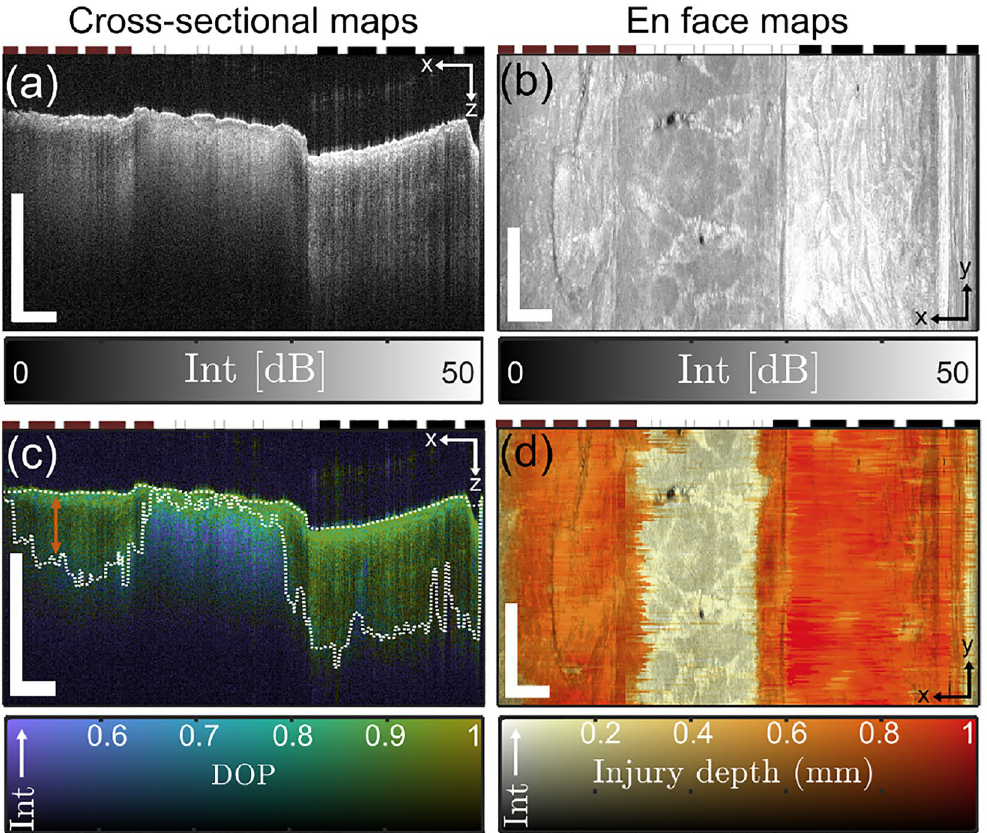
Figure 2. Porcine skin samples were imaged with a PS-OCT system after burn induction. OCT intensity images are shown for a representative cross-sectional view ( a ) and superficial en face view ( b ) for an ROI spanning a tissue region subject to 30 s burn duration (left side of each panel), no burn (center of each panel), and 60 s burn duration (right side of each panel). The degree of polarization (DOP) was spatially mapped throughout each cross-section ( c ). The surface of each tissue section was identified automatically and a DOP threshold was applied to determine the depth extent of the injured collagen in each cross section (white dashed lines). The difference between these two lines [e.g., orange arrow in ( c )], adjusted by tissue refractive index, was used to calculate the collagen injury depth for each cross section of the imaged volume to produce an en face map of DOP-based collagen injury depth ( d ) corresponding to the same ROI as ( b ). Scale bars = 1 mm. Intensity limits for 2D colorbars in ( c ) and ( d ) range from 0 dB to 50